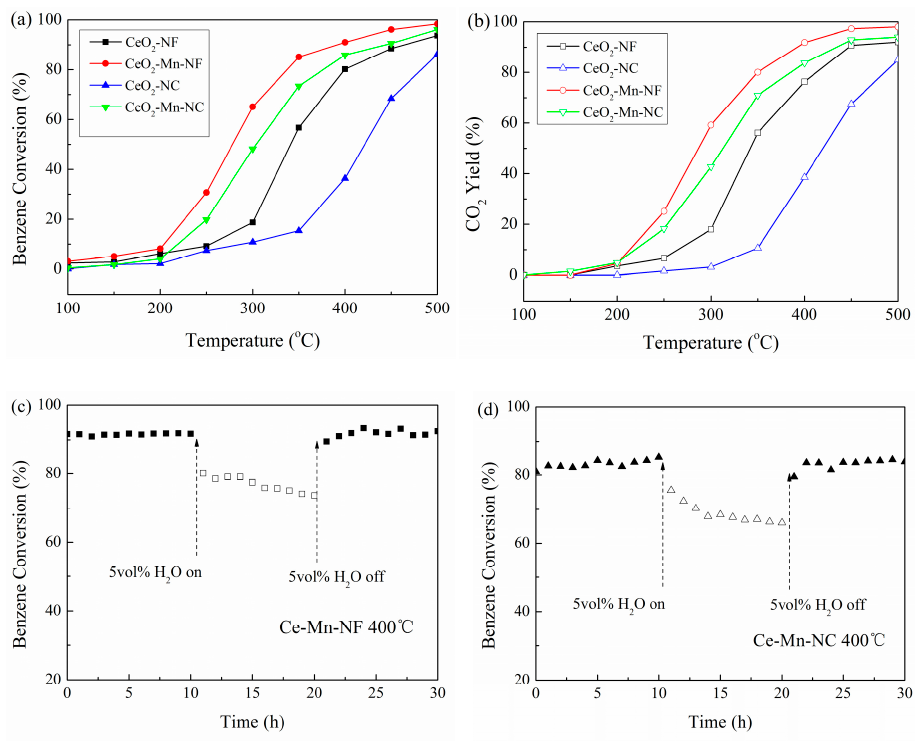
Figure 8. Benzene conversion (%, a ), CO 2 yield (%, b ) over CeO 2 -NF, CeO 2 -NC, Ce-Mn-NF and Ce-Mn-NC. Effect of water vapor on the catalytic activities of Ce-Mn-NF( c ) and Ce-Mn-NC ( d ). Water concentration = 5 vol%.